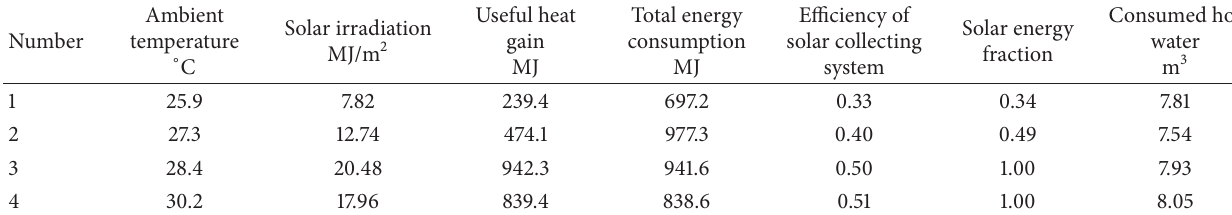
Table 9: Test results for a solar water heating system.